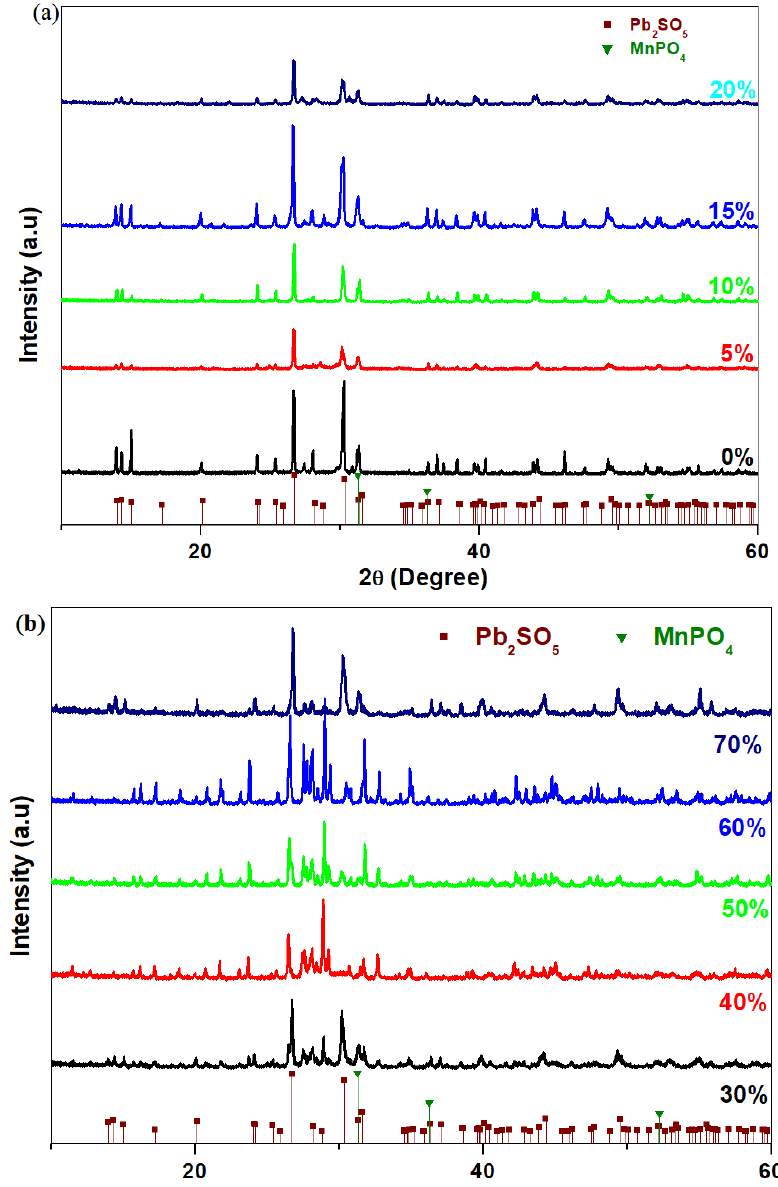
Figure 1. X-ray diffractograms of the vitreous system with the. xNaH 2 PO 4 ·5MnO 2 ·(95 − x)[4PbO 2 ·Pb] composition where ( a ) x = 0 – 20 mol% NaH 2 PO 4 and ( b ) x = 20 – 70 mol% NaH 2 PO 4 .